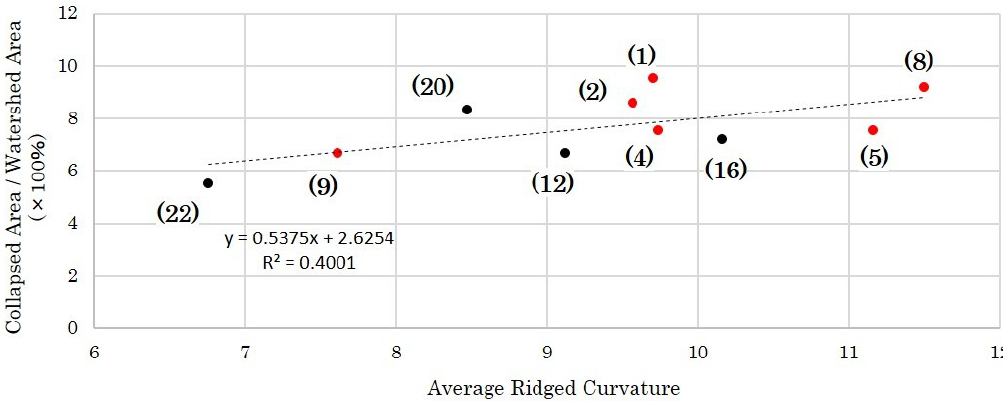
Figure 6. The relationship between the collapsed slope and the ridged curvature. (In this figure, the black circle shows the data of the left bank tributaries, the red circle shows the data of the right bank